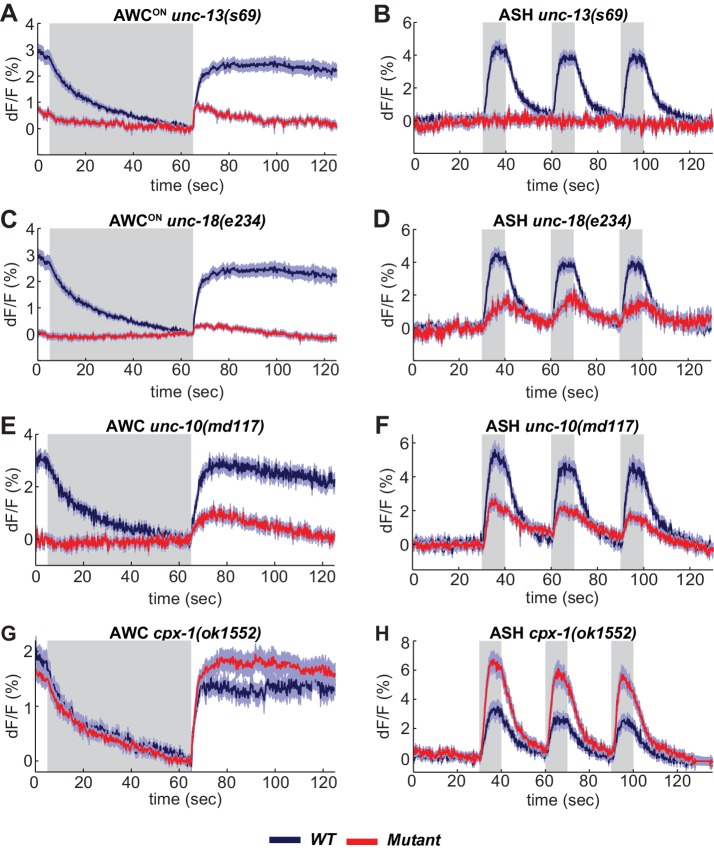
SNARE regulators differentially affect AWCON and ASH.(A,B) VGLUT-pH responses in unc-13(s69) null mutants. (A) AWCON responses in unc-13(s69), n = 25 (9 animals, 2–3 trials each) and wt, n = 33 (11 animals, three trials each). (B) ASH responses in unc-13(s69), n = 18 (7 animals, 1–3 trials each) and wt, n = 42 (14 animals, three trials each). (C,D) VGLUT-pH responses in unc-18(e234) mutants. (C) AWCON responses in unc-18(e234), n = 25 (9 animals, 1–3 trials each) and wt, n = 33 (11 animals, three trials each). (D) ASH responses in unc-18(e234), n = 22 (8 animals, 1–3 trial each) and wt, n = 42 (14 animals, three trials each). (E,F) VGLUT-pH responses in unc-10(md117) mutants. (E) AWCON responses in unc-10(md117), n = 23 (8 animals, 1–3 trials each), and wt, n = 27 (9 animals, three trials each). (F) ASH responses in unc-10(md117), n = 33 (12 animals, 2–3 trials each), and wt, n = 24 (8 animals, three trials each). (G,H) VGLUT-pH responses in cpx-1(ok1552) mutants. (G) AWCON responses in cpx-1(ok1552), n = 36 (12 animals, three trials each), and wt, n = 17 (6 animals, 2–3 trials each). (H) ASH responses in cpx-1(ok1552), n = 38 (13 animals, 2–3 trials each), and wt n = 33 (11 animals, three trials each). WT and mutants are significantly different in panels A-F and H, as detailed in Supplementary file 3B. Gray areas mark stimulus periods. Shading indicates S.E.M.10.7554/eLife.31234.012Figure 4—source data 1.Source data for Figure 4.